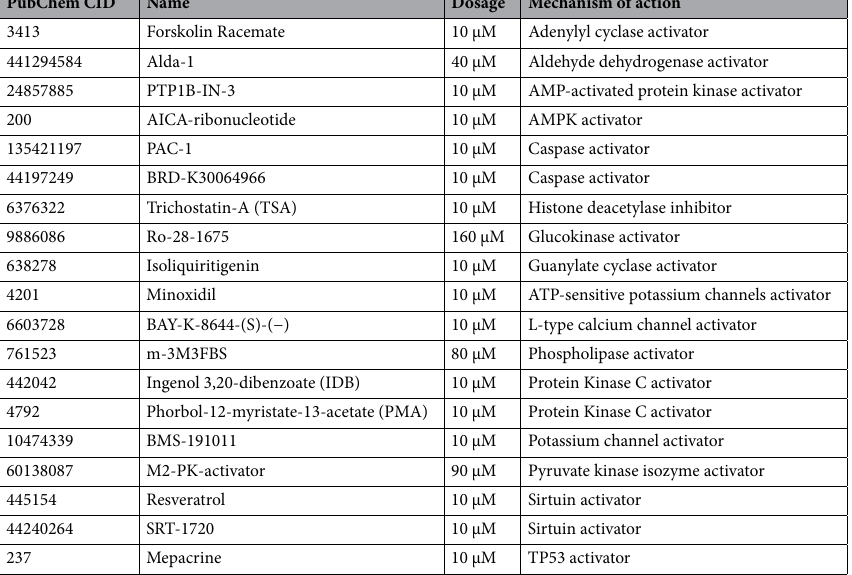
Table 2. List of 19 chemical